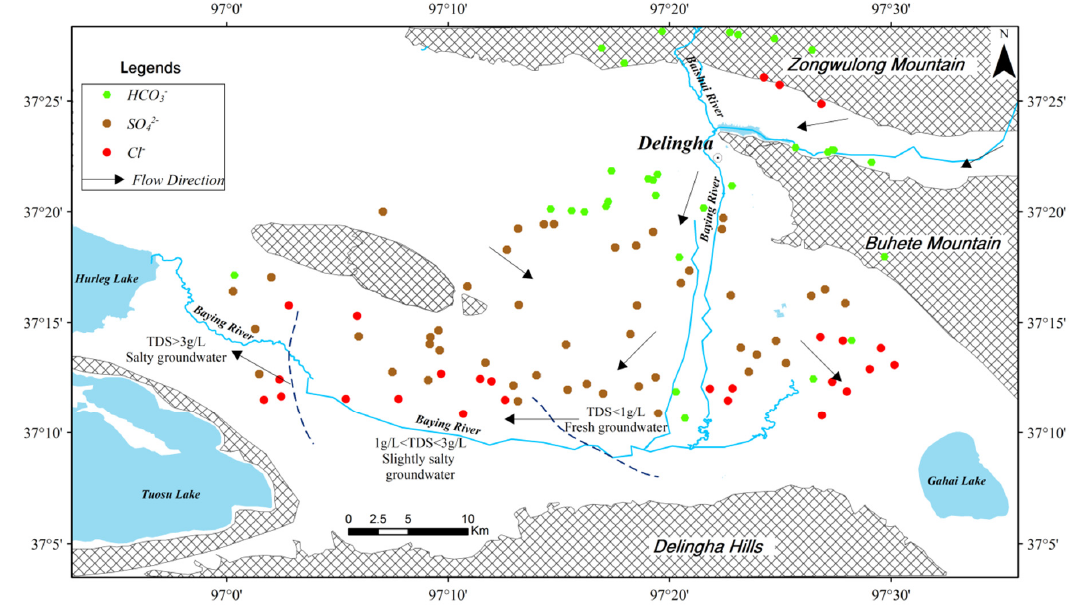
Figure 4. The distribution map of water types and Total Dissolved Solids (TDS) in the Delingha